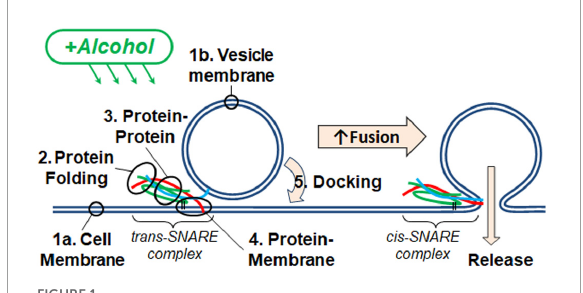
FIGURE1 Alcohol could alter fusion by acting at one or more of the five numbered targets. A SNARE-driven fusion assay was used to assess the effects of methanol and ethanol on this reduced fusion system. Other techniques with fewer components targeted one or more of the possible sites of alcohol action including: (1a,b) membranes, (2) SNARE protein folding, (3) protein-protein interactions, (4) protein-membrane interactions detected by the transition from trans - to cis -(mimicking) SNARE complex, and finally (5) vesicle docking. Membranes are shown as double blue lines; SNARE proteins are syntaxin (red), SNAP-25 (green), and synaptobrevin